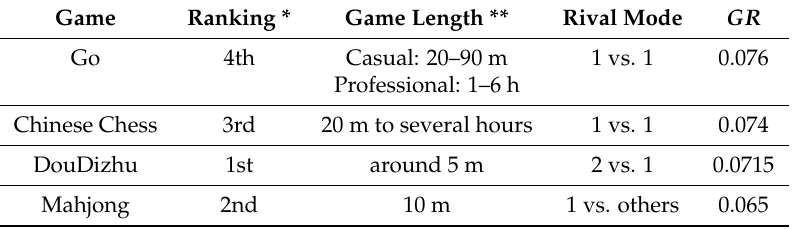
Figure 4. Download ranking adopted from the web article from http://www.youxiputao.com/articles/ 13003/. Table 14. Comparison of some well-refined board and card games in China (ordered by decreasing GR